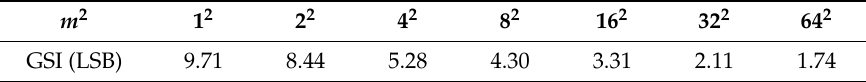
Table 1. The GSI values for different spatial oversampling factors with U thn = 0.15.